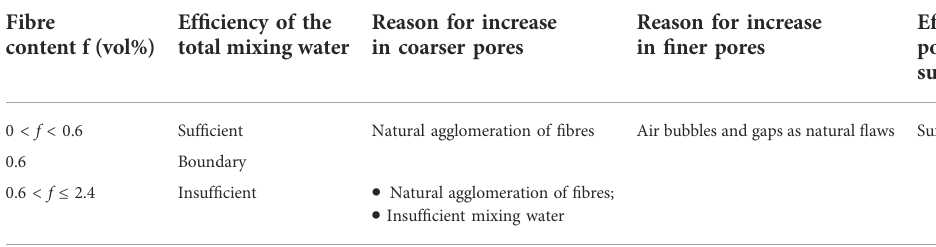
TABLE 2 Factors to dominate the increase of fi ner pores and coarser pores with the increasing fi bre dosage. Fibre Ef fi ciency of the Reason for increase content f (vol%) total mixing water in coarser pores